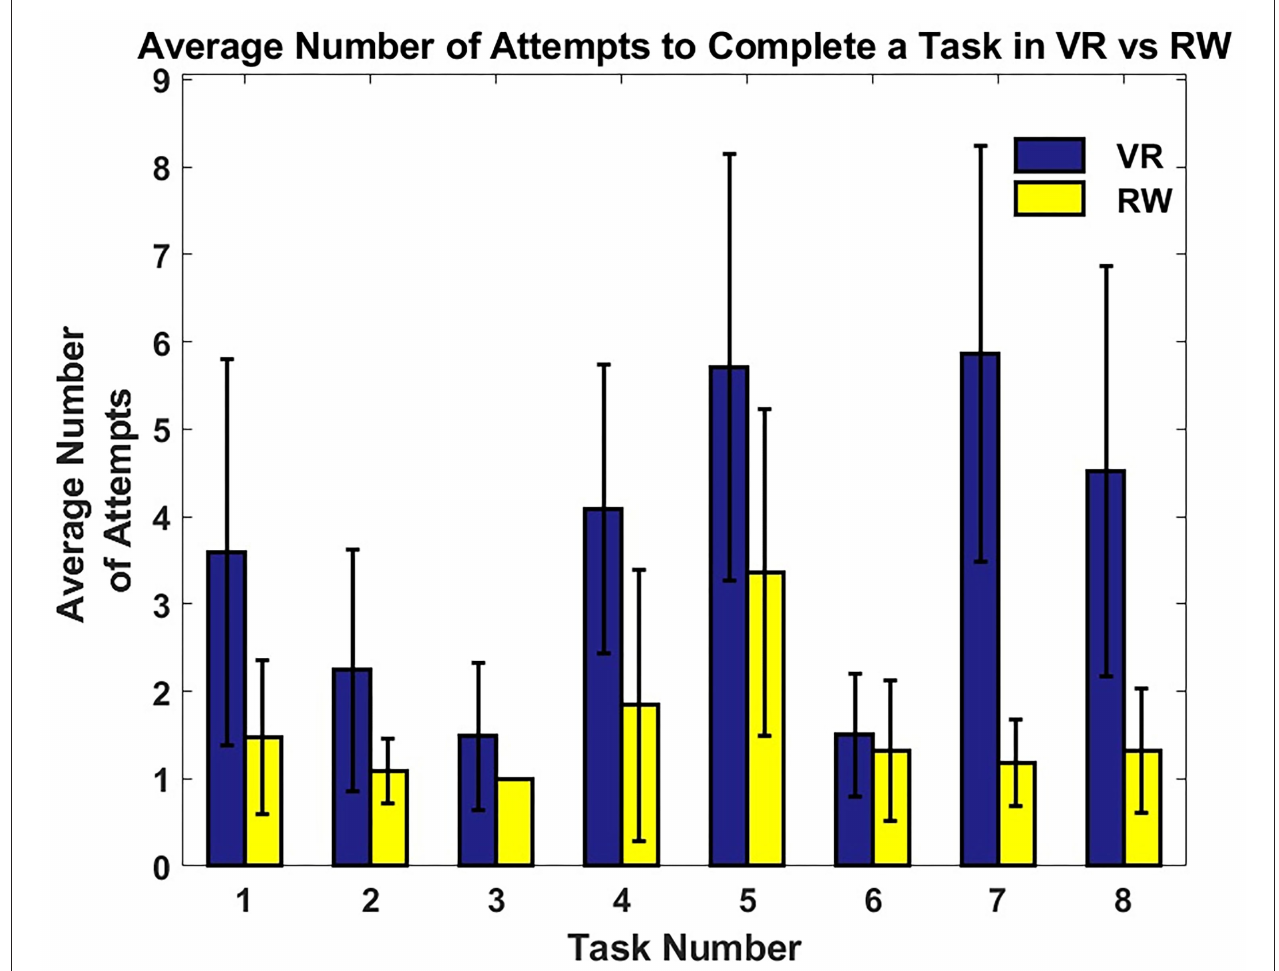
FIGURE 7 | Average number of attempts subjects made while trying to complete a task in VR vs. RW. All tasks required fewer attempts in RW than in VR. The characteristics of the items in the tasks (e.g., small size) had a more marked effect on number of attempts in VR than in RW. Error bars display standard deviation of the